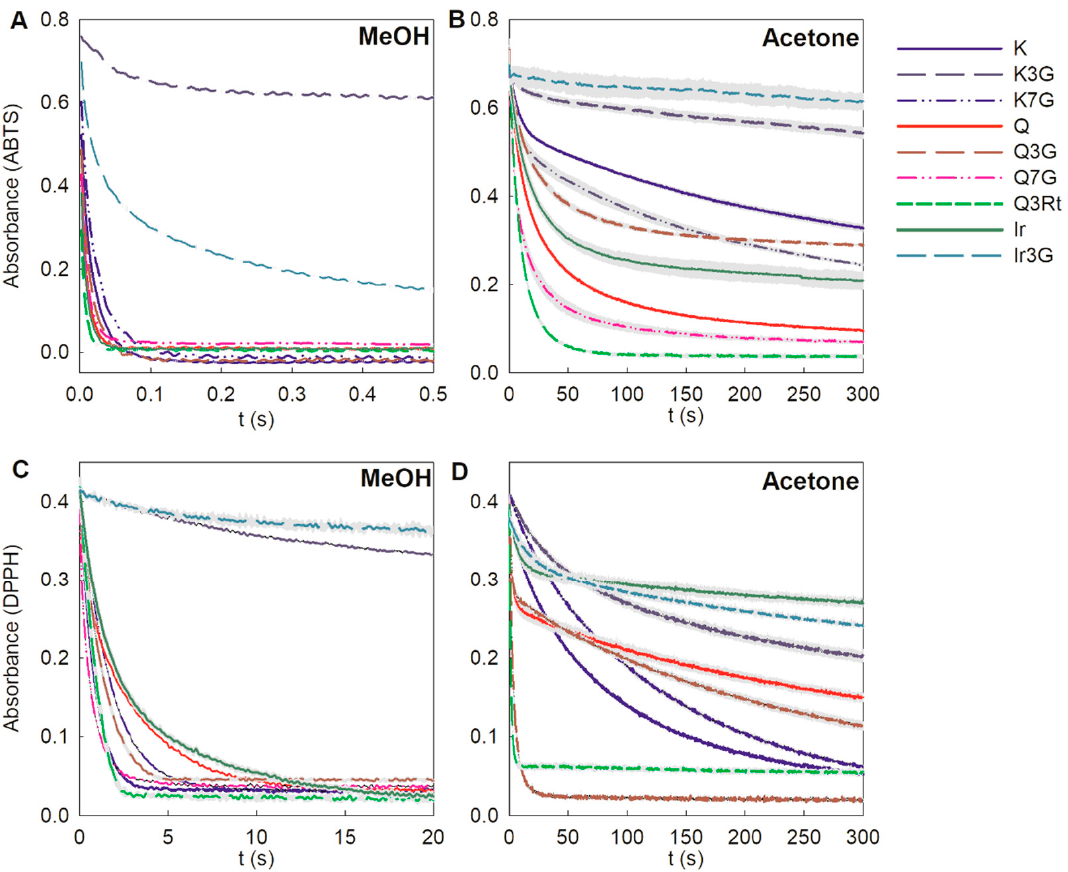
Figure 3. Decay curves of ABTS • + ( A , B ) and DPPH • ( C , D ) when quenched by flavonols in methanol and acetone, respectively. Each curve was obtained by taking the average of five curves, and the gray area represents the SE of each curve. Names of the dihydrochalcone compounds are presented in Figure 1.